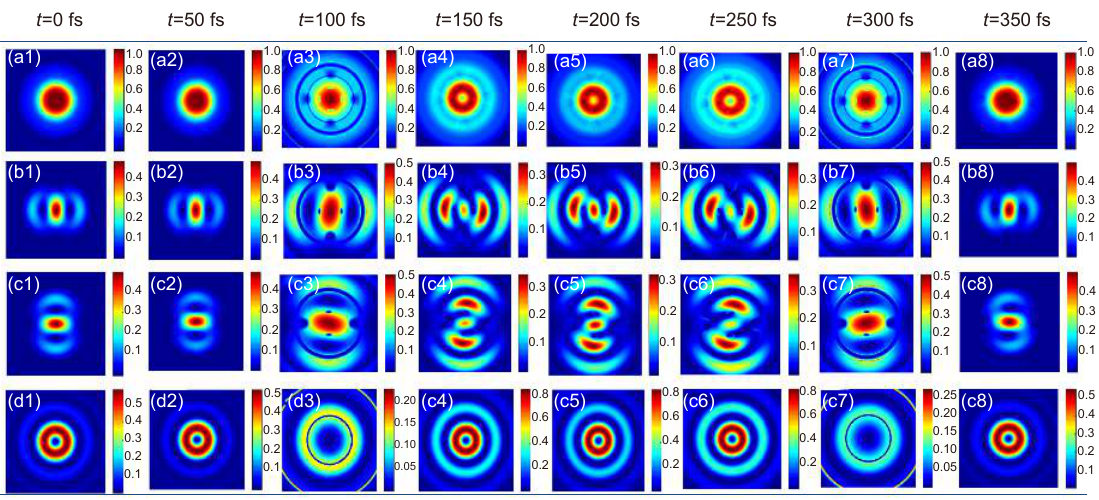
Fig. 3 | The focused field distributions of radially polarized light with the first-order vortex at different temporal intervals. The total in- tensity distributions | E t | 2 ( a1 – a8 ) as well as the transverse | E x | 2 ( b1 – b8 ), | E y | 2 ( c1 – c8 ) and the longitudinal | E z | 2 ( d1 – d8 ) field components in the x−y plane with the periodic time of t = 0 fs (a1–d1), 50 fs (a2–d2), 100 fs (a3–d3), 150 fs (a4–d4), 200 fs (a5–d5), 250 fs (a6–d6), 300 fs (a7–d7), and 350 fs (a8–d8), respectively. Parameters are the same as those in Fig. 2.